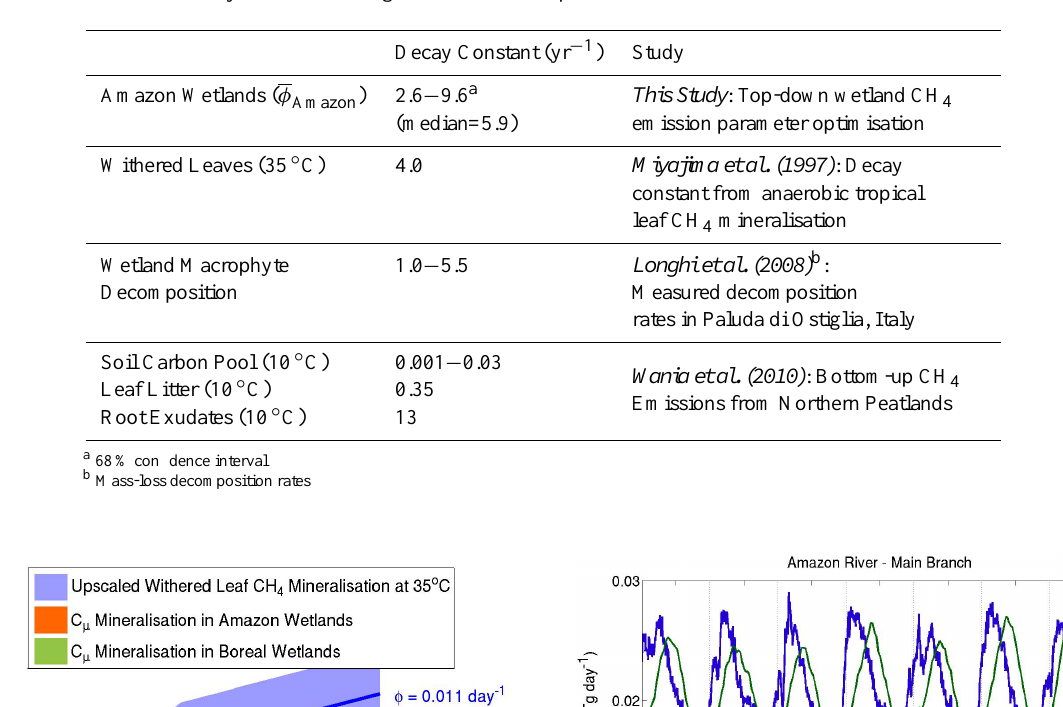
Table 1. Model and observed decay constants for organic matter decomposition in anaerobic environments.